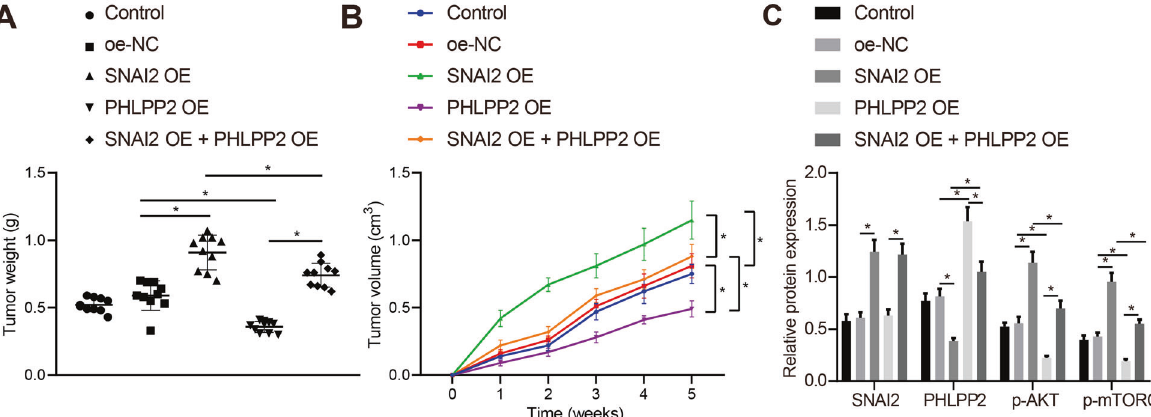
Fig. 6 SNAI2 promotes in vivo tumorigenesis of glioma by inhibiting the PHLPP2 to activate the Akt pathway. A The weight of tumor xenografted in nude mice in the presence of oe-NC, oe-SNAI2, oe-PHLPP2, or oe-SNAI2 + oe-PHLPP2. B The volume of tumor xenografted in nude mice in the presence of oe-NC, oe-SNAI2, oe-PHLPP2, or oe-SNAI2 + oe-PHLPP2. C p-Akt level in the presence of oe-NC, oe-SNAI2, oe- PHLPP2, or oe-SNAI2 + oe-PHLPP2 in nude mice xenografted with tumor as determined by Western blot assay. * p < 0.05 vs. nude mice xenografted with tumor injected with GSCs expressing oe-NC, si-NC, oe-SNAI2, or oe-PHLPP2. Each cell experiment was repeated three times independently. n =